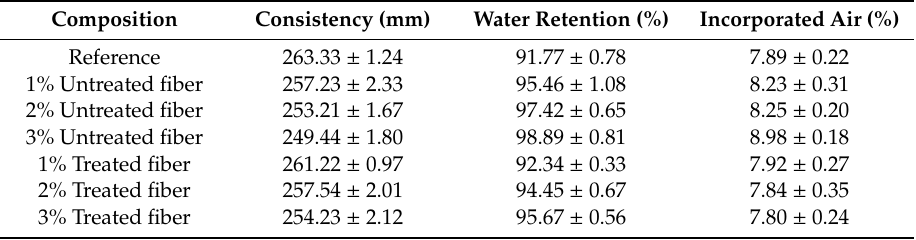
Table 4. Results of fresh state